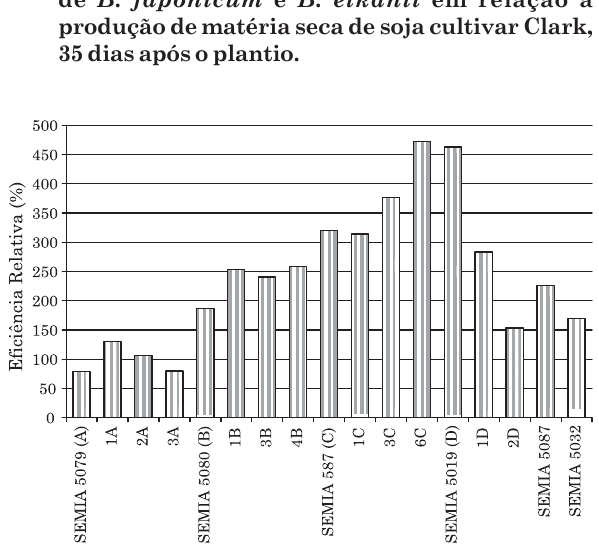
Figura 2. Índices de eficiência relativa dos tratamentos inoculados com estirpes e variantes de B. japonicum e B. elkanii em relação à produção de matéria seca de soja cultivar Peking, 35 dias após o